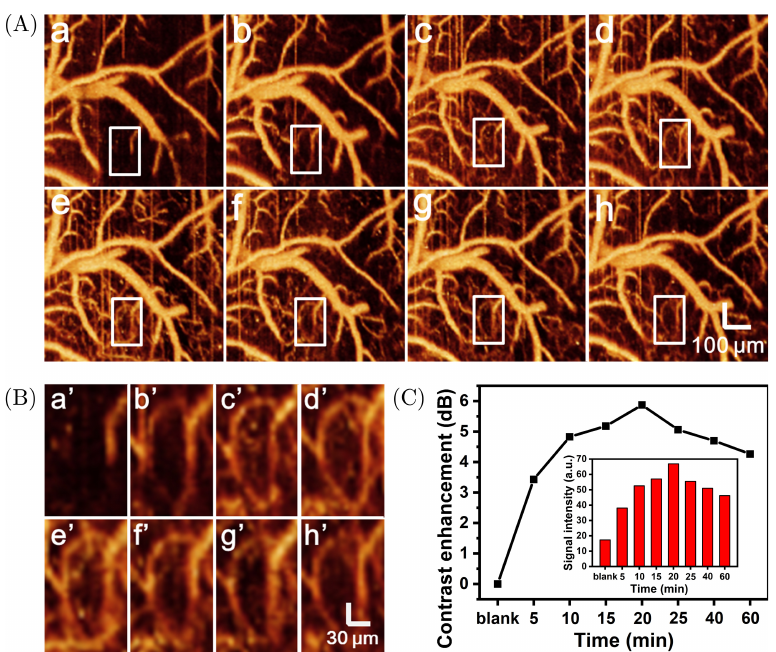
Fig. 8. (A) 3D OCT images of cerebral blood vessels in mice in the absence (a) and presence of PEG-GNRs (1 nM) at various time points, i.e., (b) 5, (c) 10, (d) 15, (e) 20 (f) 25, (g) 40 and (h) 60 min; (B) Magni¯ed images of representative blood vessels marked with white solid rectangles in (A); (C) Curve of the contrast enhancement of ROIs corresponding to (B); The inset showed the OCT signal intensity for (B).